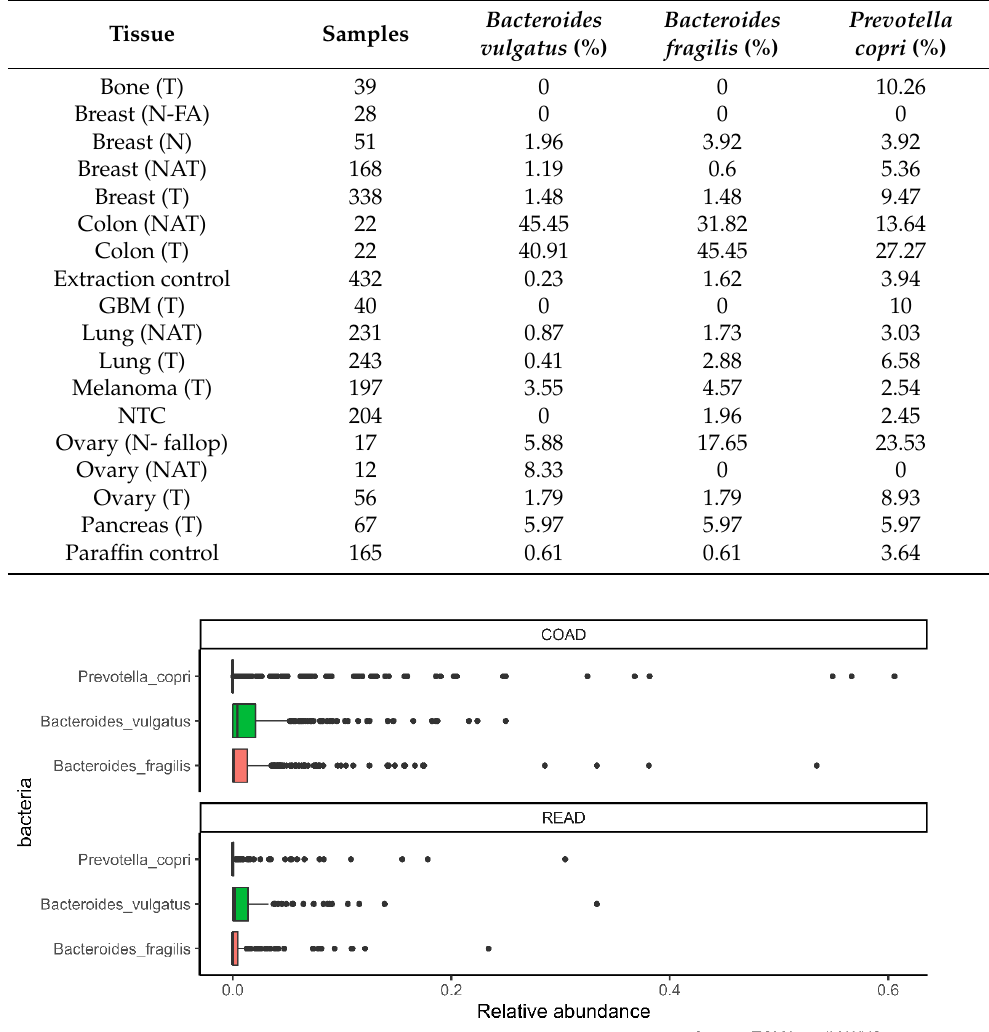
Table 1. Infiltration of Bacteroides fragilis , Bacteroides vulgatus , and Prevotella copri in tumor tissues. Tu- mor (T), normal adjacent tissues (NAT), normal fibroadenoma (N-FA), and negative controls from [22] were included in the analysis. The % of the positive samples, defined as samples that have more than zero normalized reads of the bacterium, is reported. Contaminants included negative controls that were processed with the samples, including 432 DNA extraction controls and 204 polymerase chain reaction (PCR) no-template controls (NTCs), and 165 paraffin-only samples taken from the margins of the paraffin blocks (without tissue).